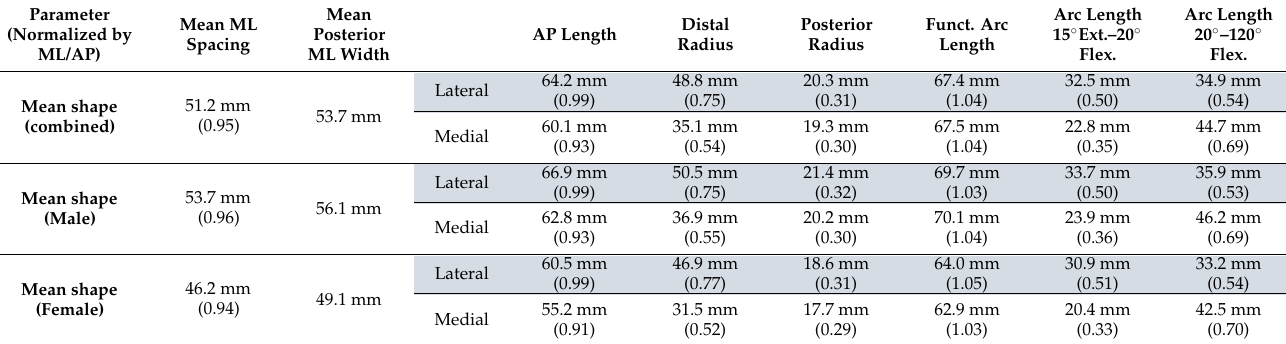
Table 2. Results of the geometric parameter analysis: measures of the mean shapes of the male, female, and combined population are listed. In addition, normalized measures are given in brackets.